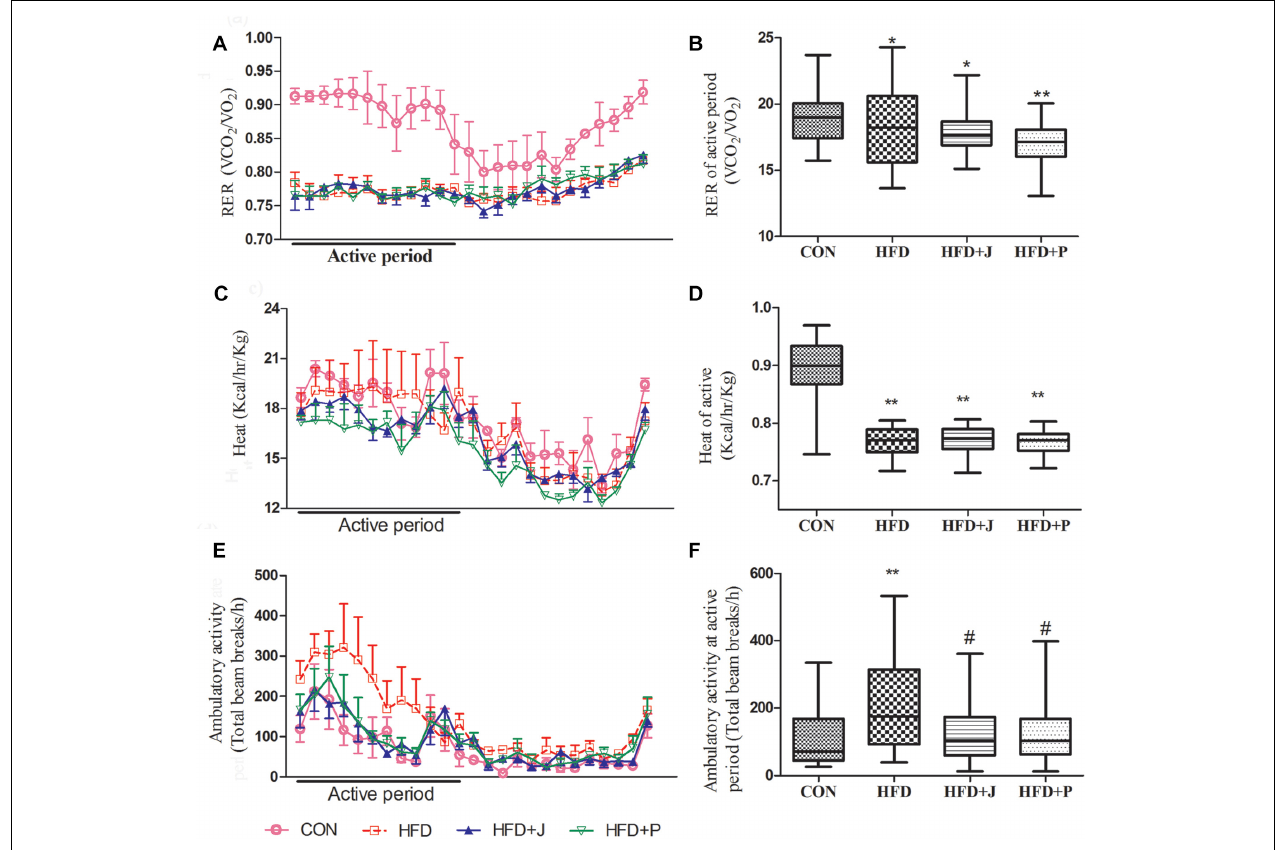
FIGURE 3 | Effects of Lactobacillus jensenii IgA-21 and Pediococcus acidilactici FS-1 on the respiratory exchange ratio (RER) (A,B) , heat (C,D) , and ambulatory activity (E,F) in high-fat diet (HFD) mice. Bar graphs represent median range values during the active cycle over 48 h. CON, control group; HFD, high-fat diet group; HFD + J, high-fat diet group treated with L. jensenii IgA-21; HFD + P, high-fat diet group treated with P. acidilactici FS1. RER, respiratory exchange ratio. Data of A , C and E are presented as mean ± SD ( n = 8). ∗ P < 0.05 (HFD versus CON); ∗∗ P < 0.01 (HFD versus CON); # P < 0.05 (bacterial treatment versus HFD). Comparisons were made with Kruskal-Wallis ANOVAs and the Bonferroni post hoc method to arrive at adjusted P -values.